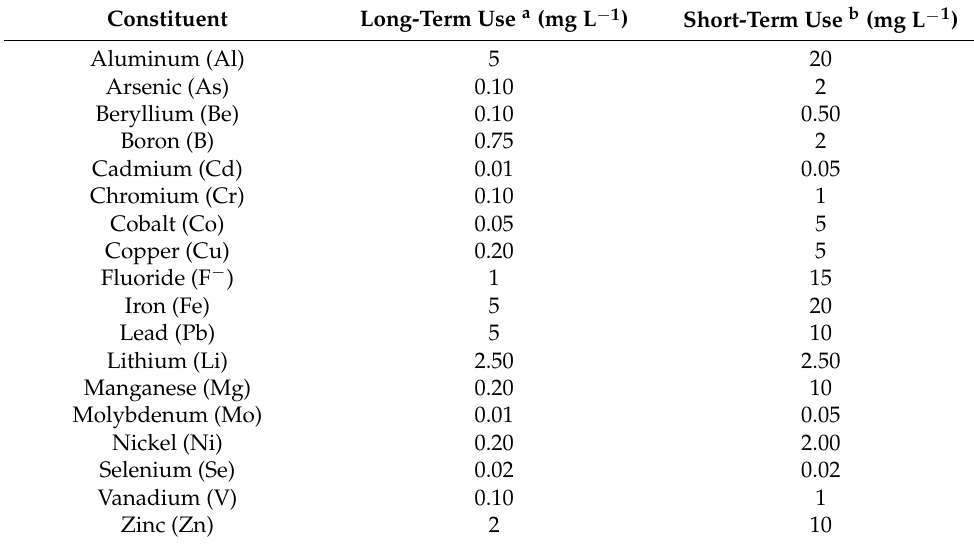
Table 7. Recommended limits for constituents in TW for irrigation